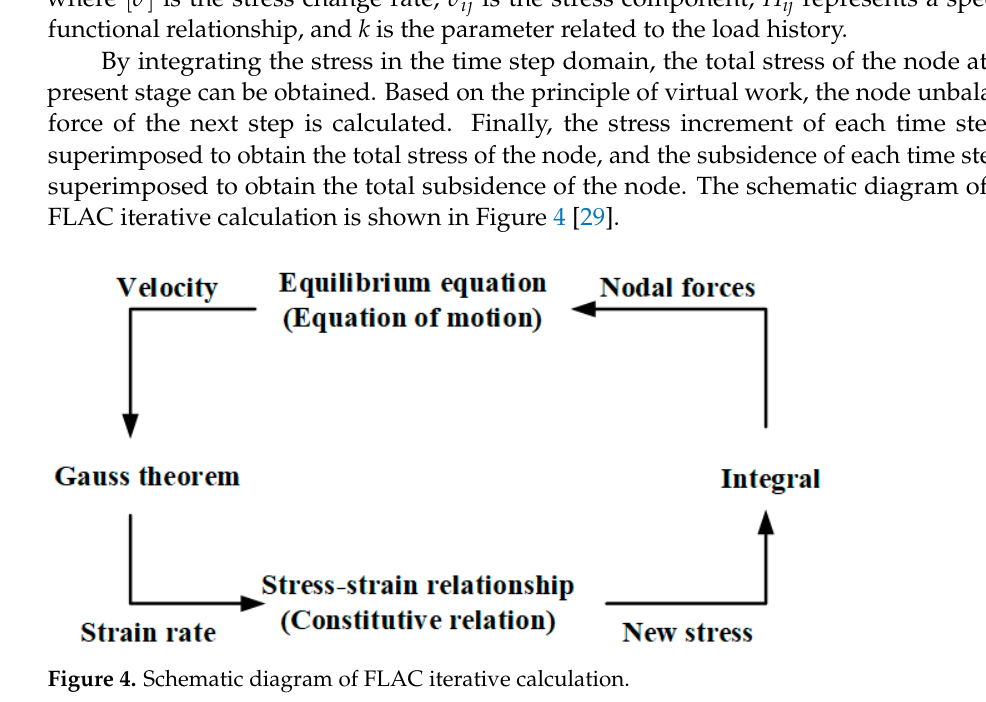
Figure 4. Schematic diagram of FLAC iterative